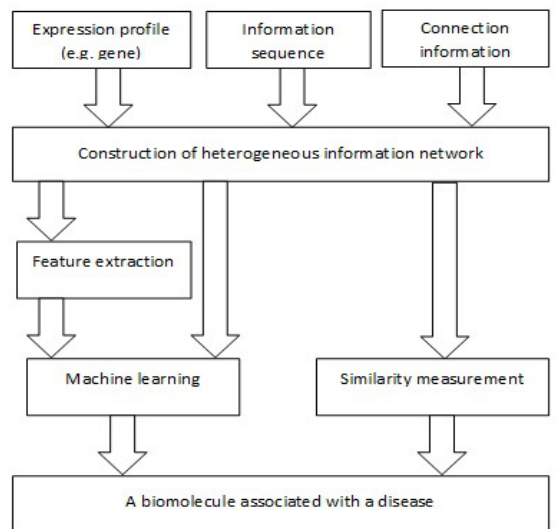
Figure 14. The process of predicting